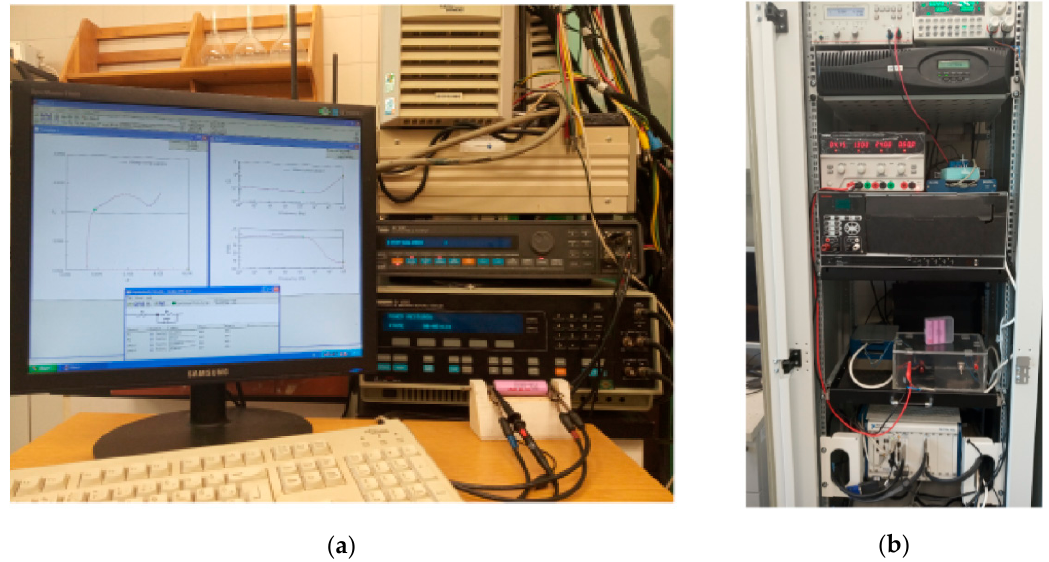
Figure 1. Experimental setups for ( a ) EIS (frequency-domain) and ( b ) instantaneous resistance (time-domain) measurements. The measured cell was removed from the insulator box for the duration of the photoshoot for the purpose of better visual representation.